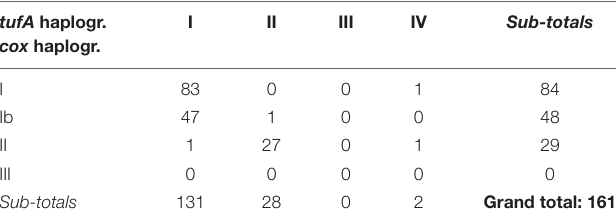
TABLE 2 | Correspondence among cox haplogroups and tufA haplogroups from SE Pacific. tufA haplogr. cox haplogr.